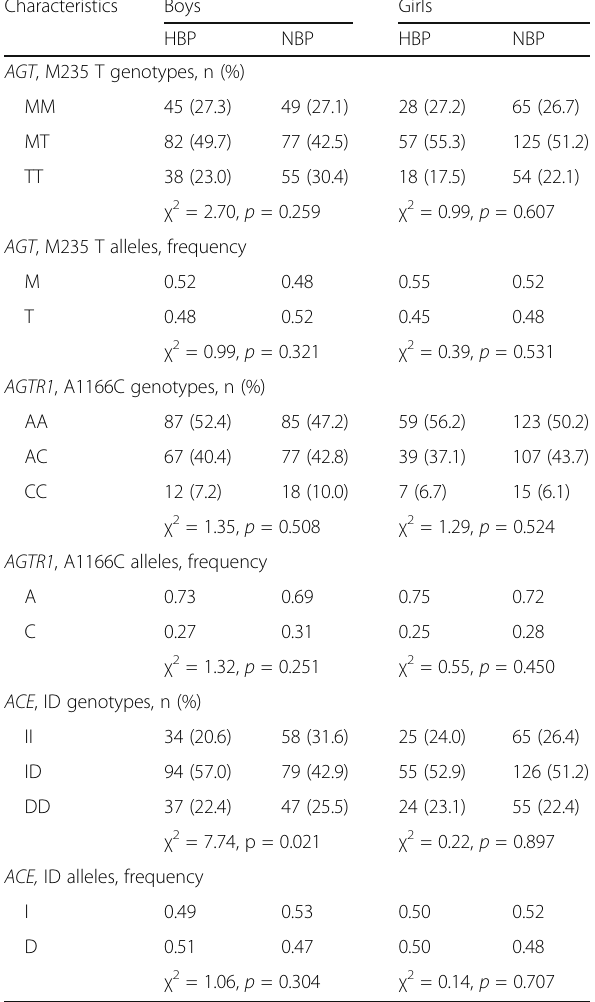
Table 2 Distribution of the AGT, AGTR1, and ACE genotypes and the frequency of alleles in the study population